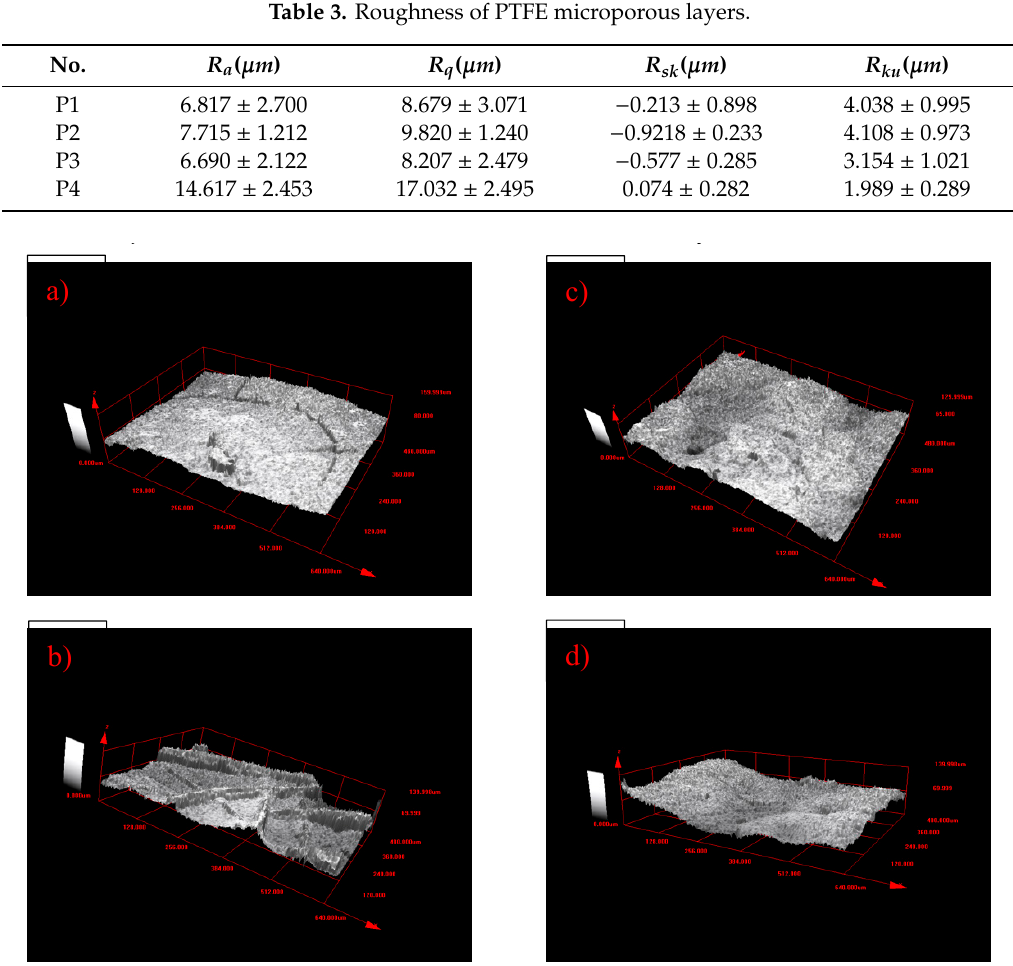
Figure 7. 3D morphology of the PTFE microporous layer ( a ) P1; ( b ) P2; ( c ) P3; and ( d ) Table 3. Roughness of PTFE microporous layers.